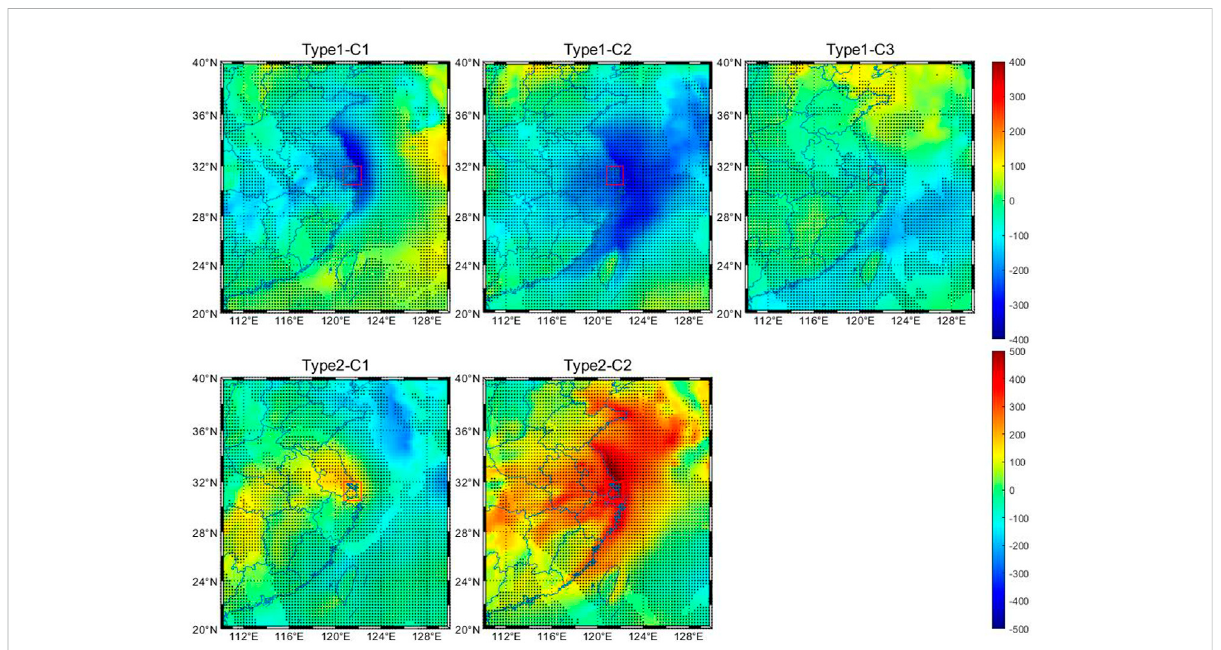
FIGURE 7 Anomalies of boundary layer height in 5 clusters. The solid blue line in the background indicates the provincial boundaries of China. Different subtitles representdifferentclusters.The blackdotsindicatethat thegridsareabovethe99%con fi dencelevel( p < 0.01).The solidredboxmarksthe location of Shanghai. Unit: m.